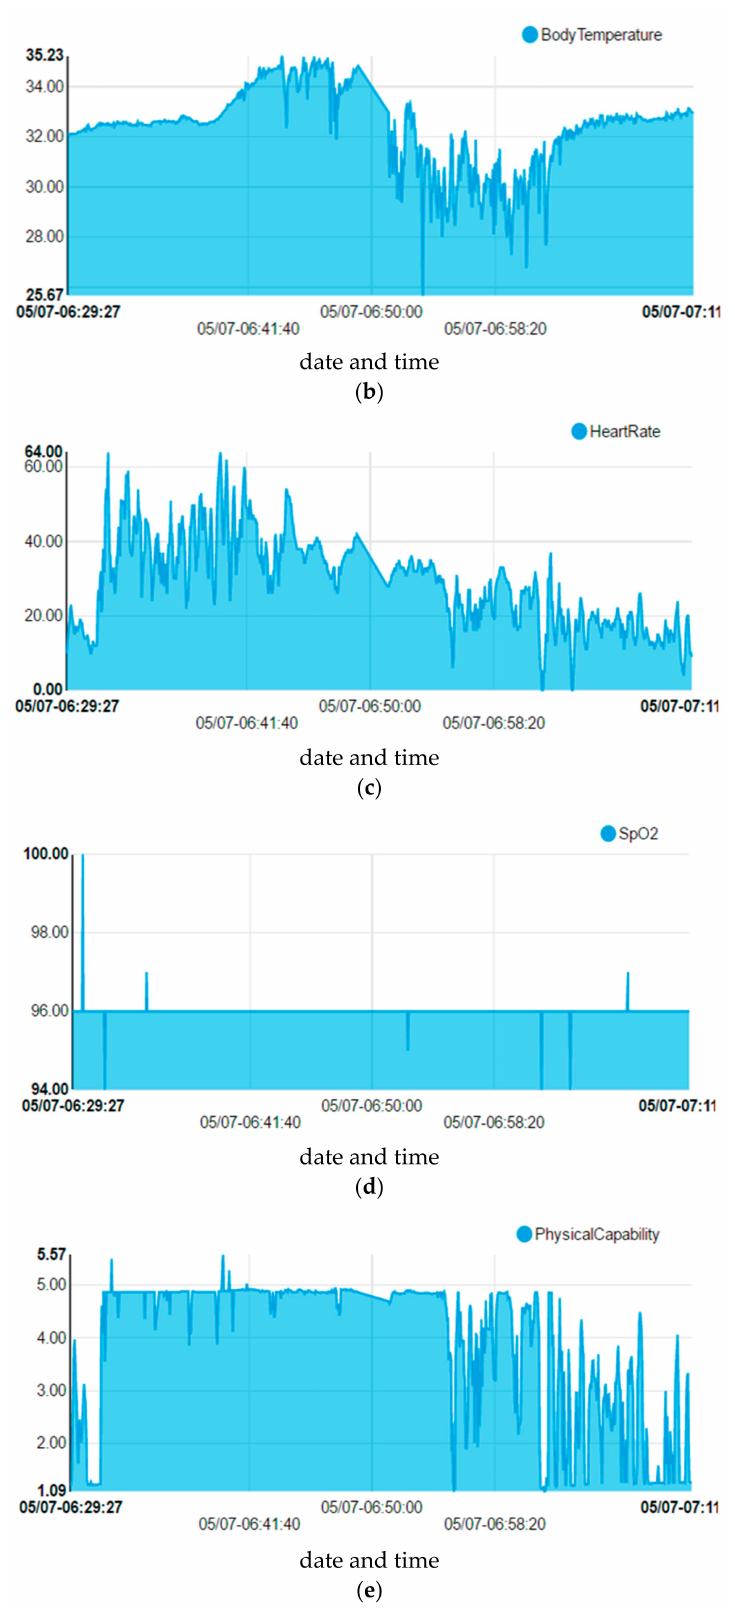
Figure 16. Respective sensing data: ( a ) risk factor, ( b ) body temperature, ( c ) heart rate, ( d ) SpO 2 , ( e ) physical